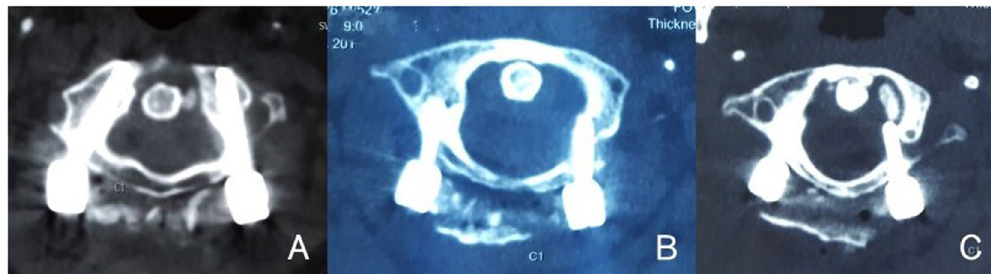
Figure 3. CT images were graded by the correctness of screw placement according to Hojo. ( A ) Grade 0 (G-0); ( B ) Grade 1 (G-1); ( C ) Grade 2 (G-2).